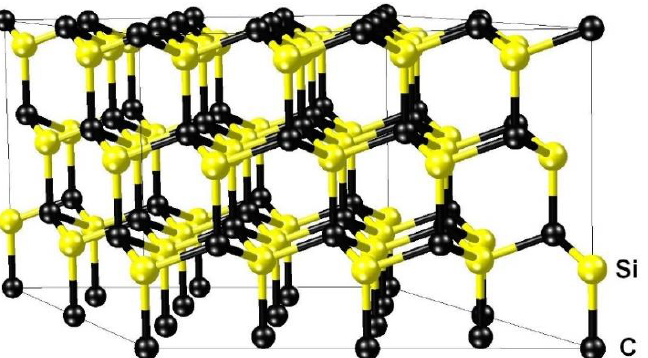
Figure 8. The model system containing 36 Si atoms and 36 C atoms with periodic boundary condi- tions in all three dimensions and initial size parameters a = b = 10.68 Å , α = 60 °, and c = 7.55 Å . Such a displacement of an atom is best described by the Nudged Elastic Band